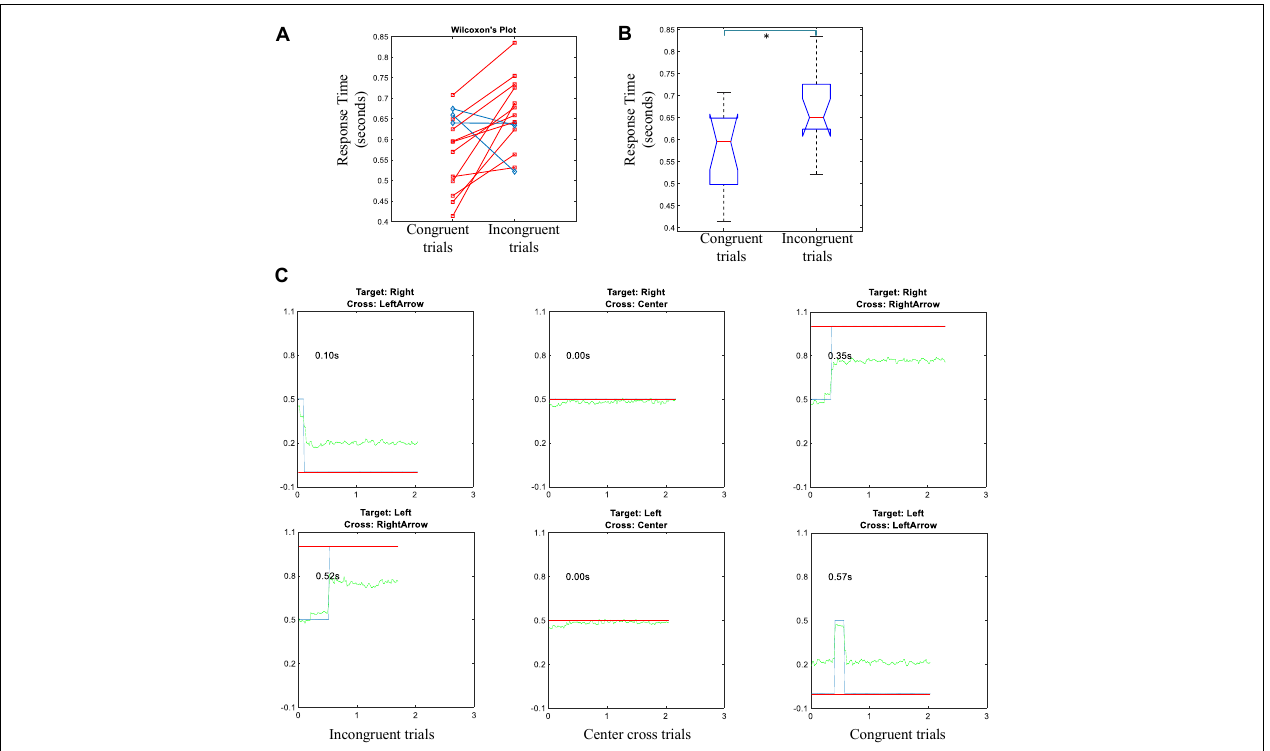
FIGURE 6 | Response time of the gaze shift and fixation task. (A) The average response time of congruent trials vs. incongruent trials for each individual, the distribution is used for Wilcoxon’s sign rank test. Red lines represent the response time of incongruent trials is longer than that of congruent trials. Blue lines show that the opposite holds. (B) Box plot of the group average response time of congruent trials vs. incongruent trials ( ∗ means p < 0.05). (C) An example of thresholding the gaze shift and fixation for a particular subject in a randomly selected run. Green lines represent gaze fixation trajectory in the pre-feedback period; blue lines demonstrate the rectified trajectories after thresholding; red lines indicate the correct value for an indicated gaze fixation cue. Left column: incongruent trials, middle column: center cross trials, right column: congruent